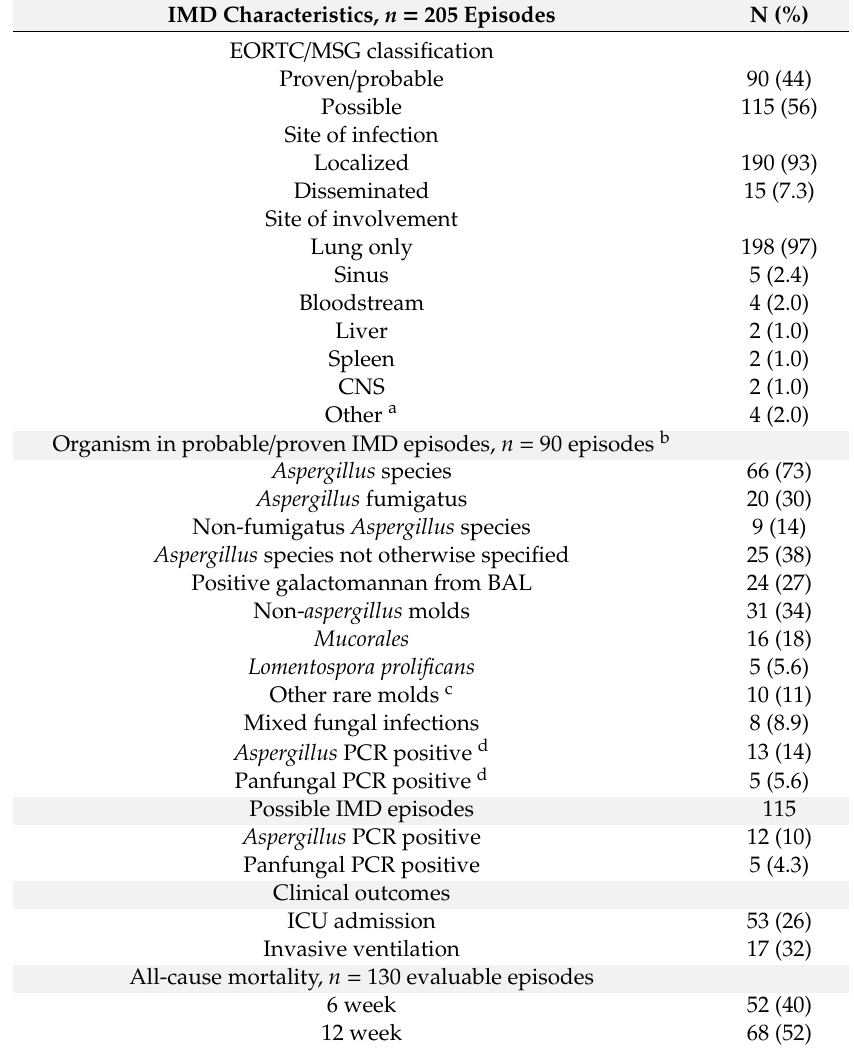
Table 2. Characteristics of IMD